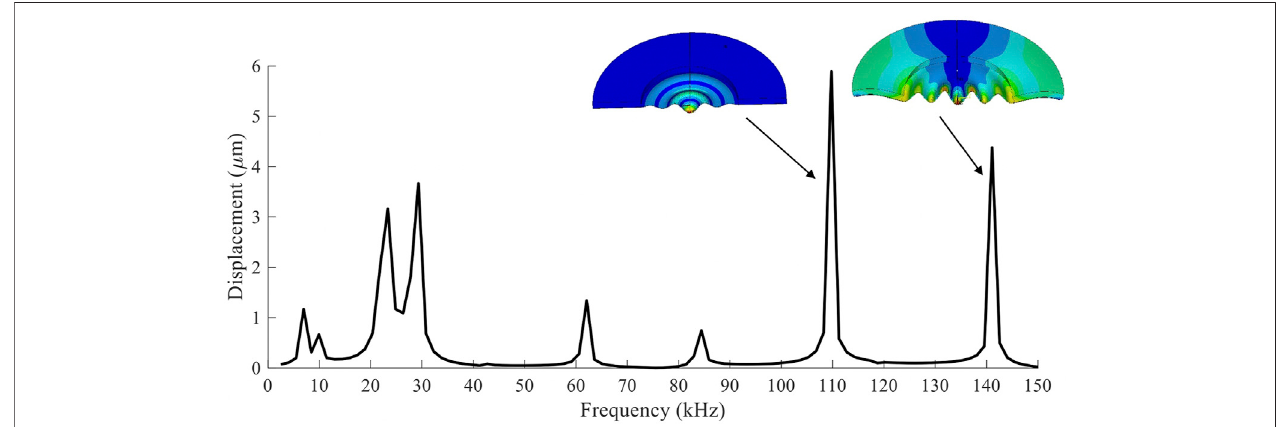
FIGURE 3 | The displacement at the center of the mesh was measured through FEM during a frequency sweep. The vibration modes of the two largest peaks are also shown.